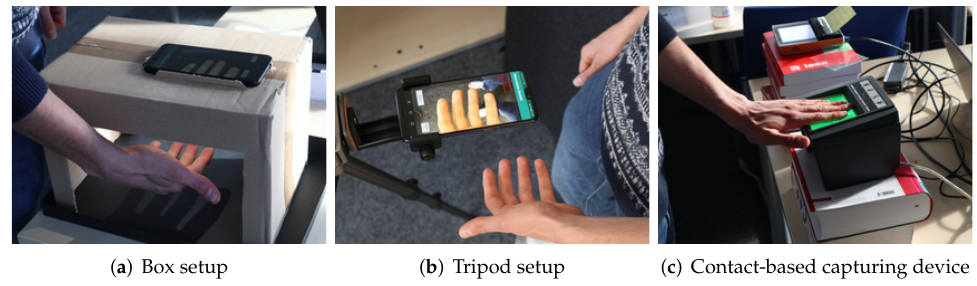
Figure 6. Capturing device setups during our experiments. Table 2. Technical specifications of the contactless capturing devices used during the data acquisition. Device